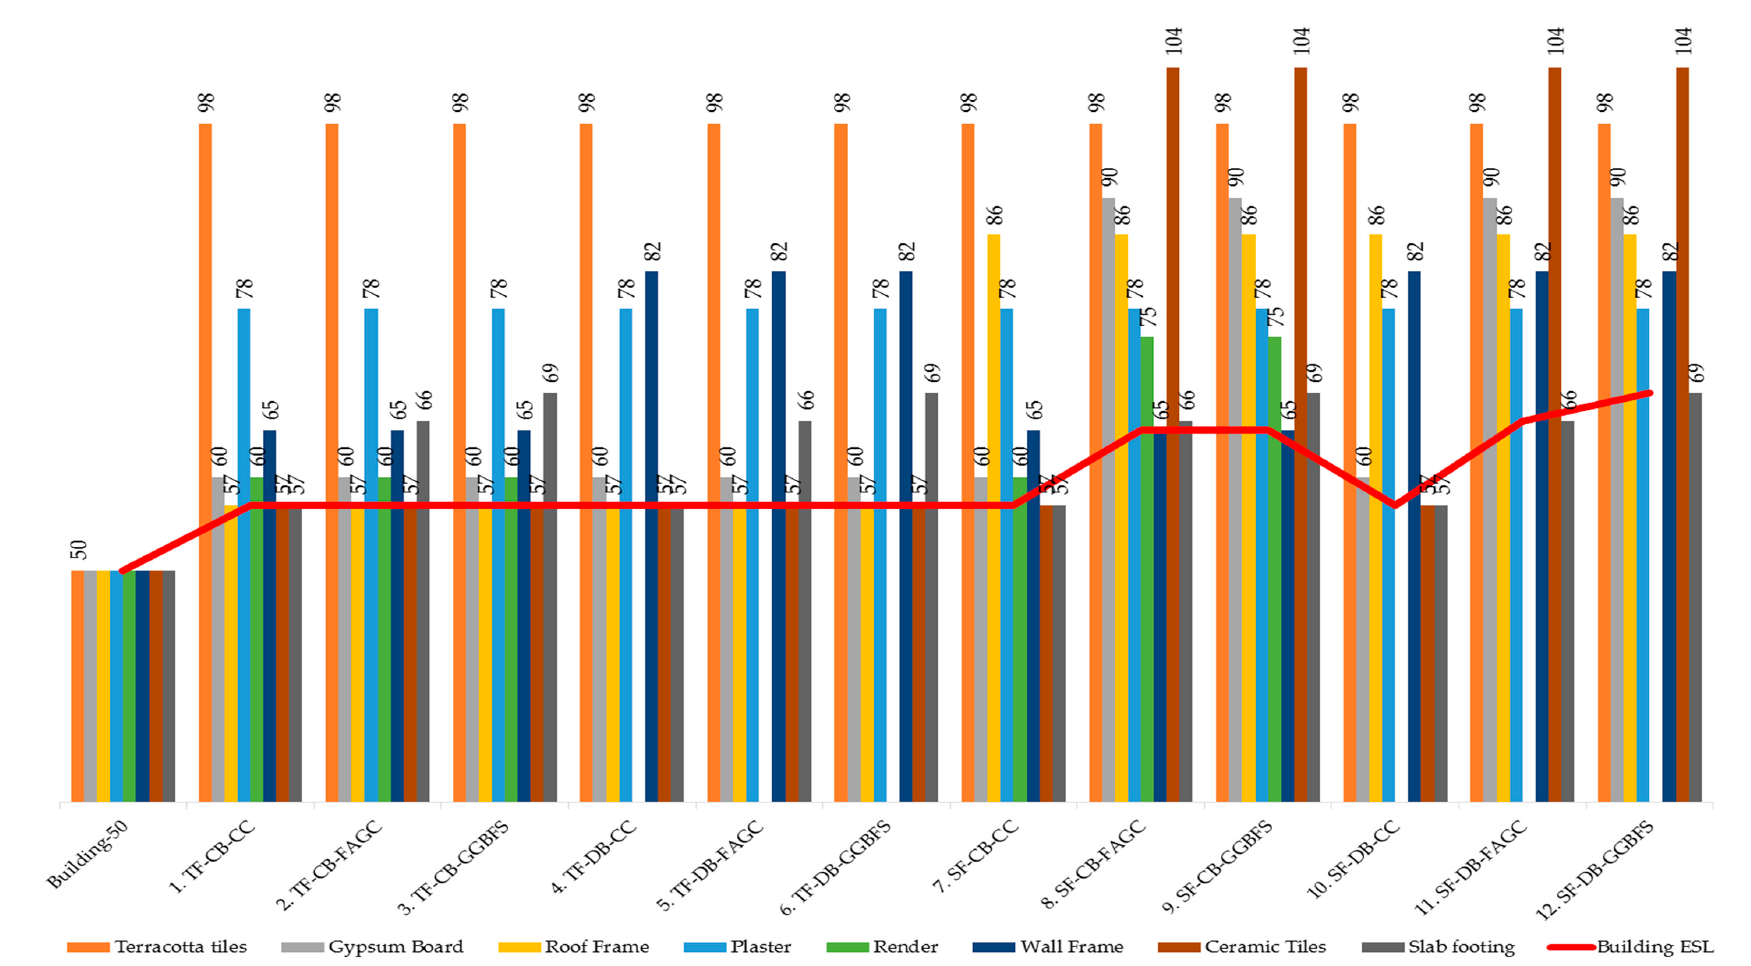
Figure 2. Remaining service life of building components at Post-Use Figure 2 : Remaining service life of building components at Post-Use Stage